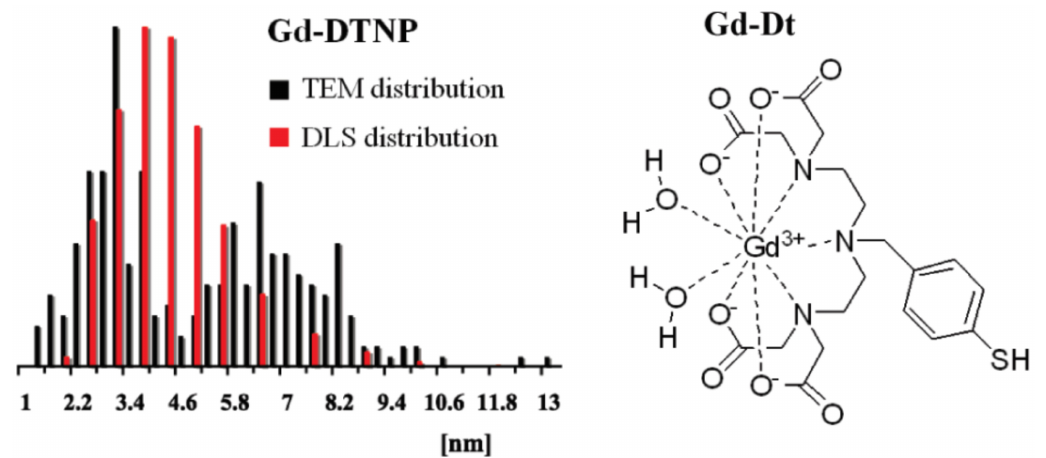
Figure 27. Au NPs of Gd 3+ complexes for MRI uses as designated in [191]. Reproduced by reference permission [191], ACS,